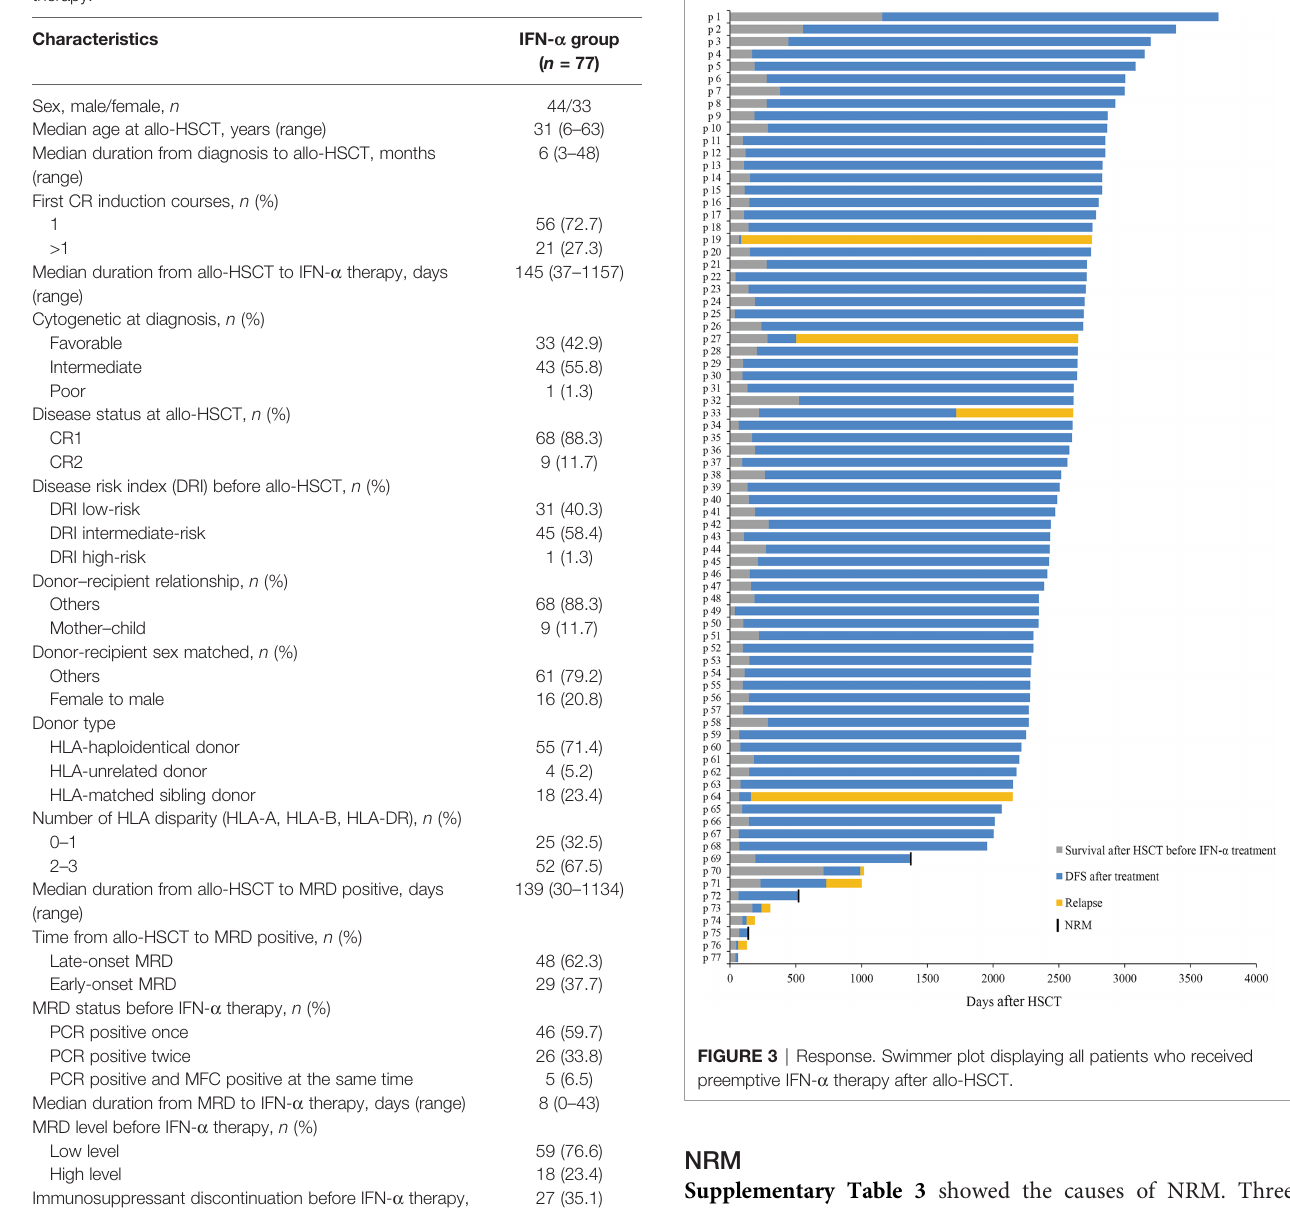
TABLE 1 | Patient characteristics of patients receiving preemptive IFN- a therapy.